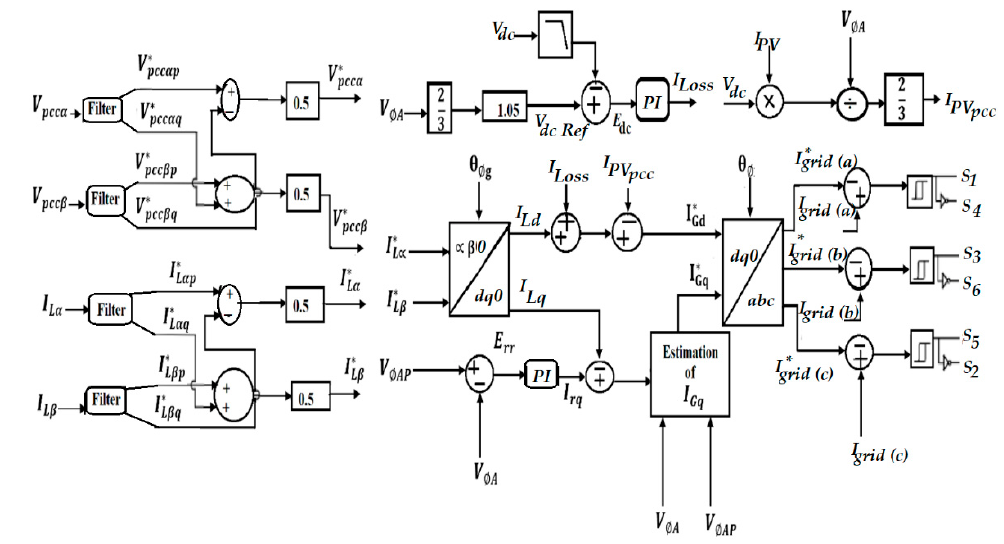
Figure 11. Generated Pulse for